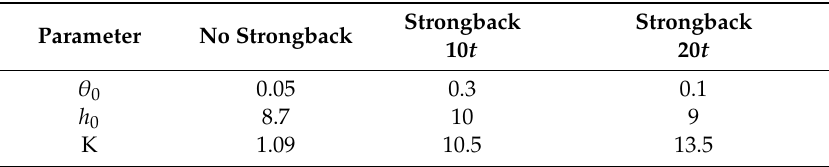
Table 2. Input parameters for angular distortion estimation.